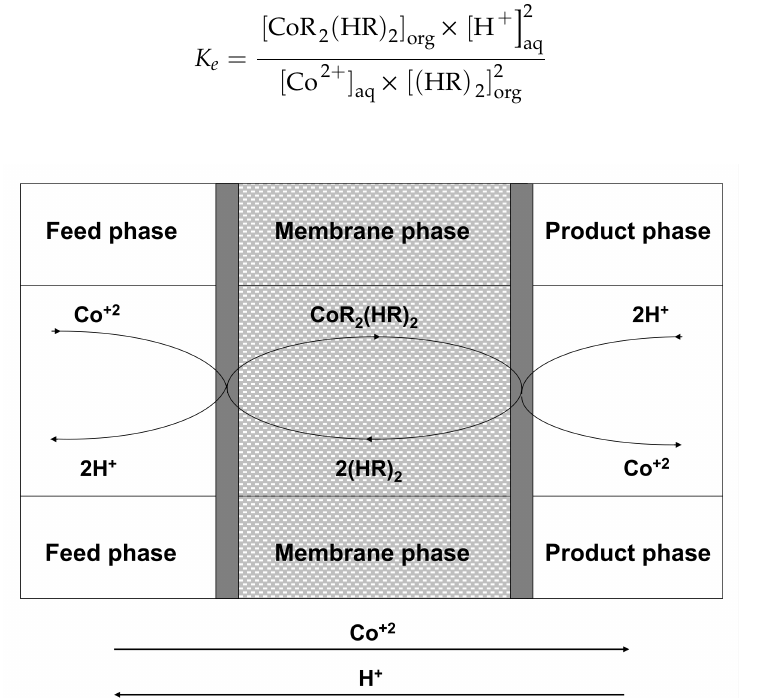
Figure 1. Diagram of the coupled counter-transport of Co(II) ions using D2EHPA as carrier and H +